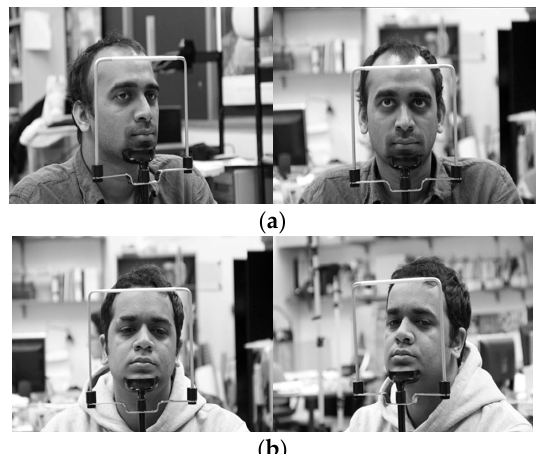
Figure 23. Examples of correct classification of frontal face image. ( a ) Right image selected; ( b ) Left image selected.